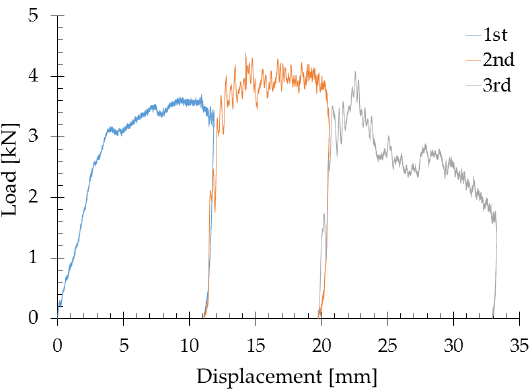
Figure 9. Loading and unloading curves for a Type II specimen subjected to repeated impacts at an impact energy equal to 35 J.